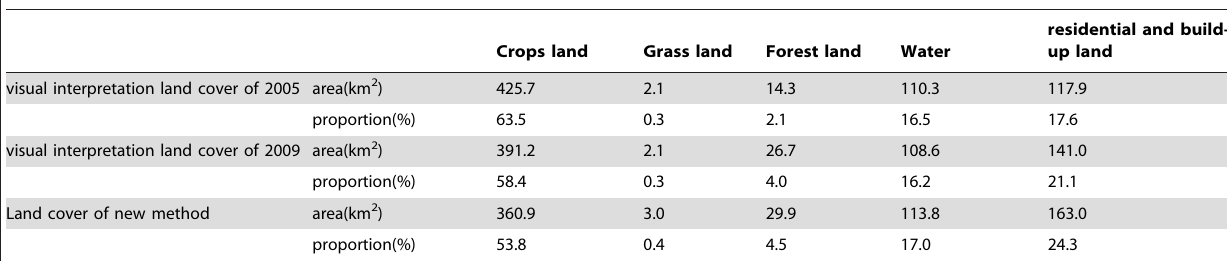
Table 1. Statistics of five land cover classes of the three classification